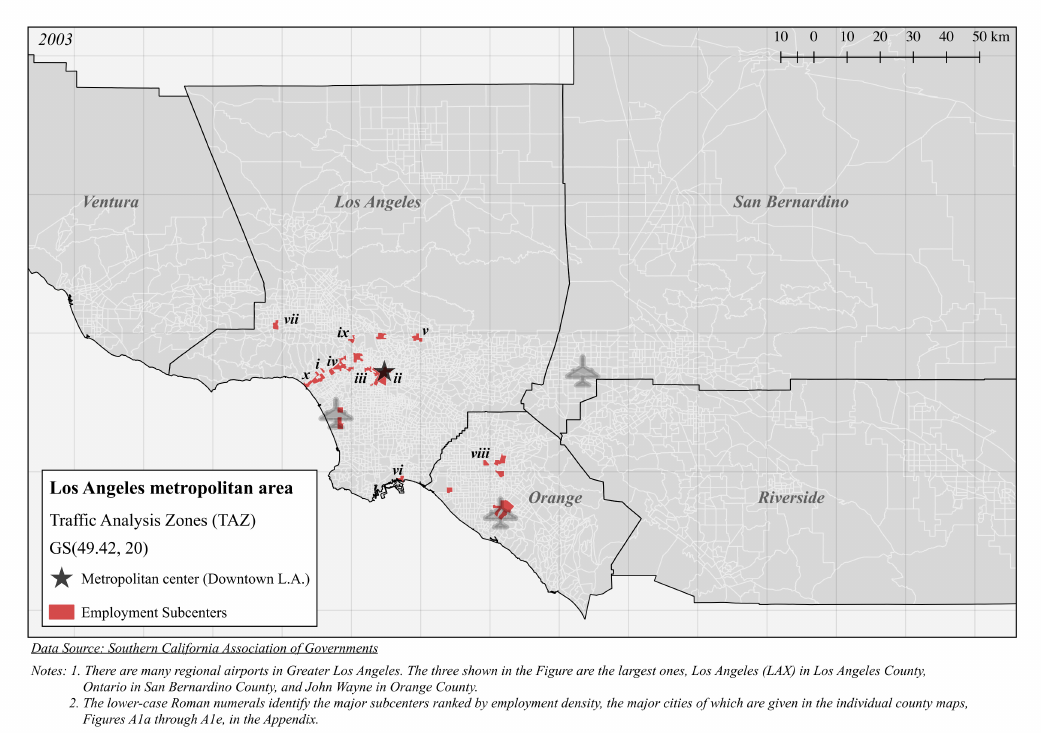
Figure 1. Los Angeles metropolitan area subcenters identified by GS(49.42,